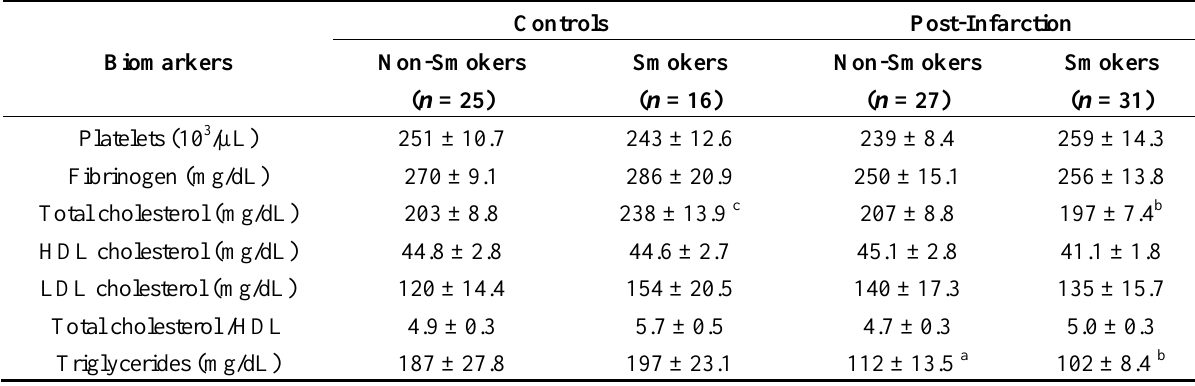
Triglycerides (mg/dL) 187 ± 27.8 102 ± 8.4 b